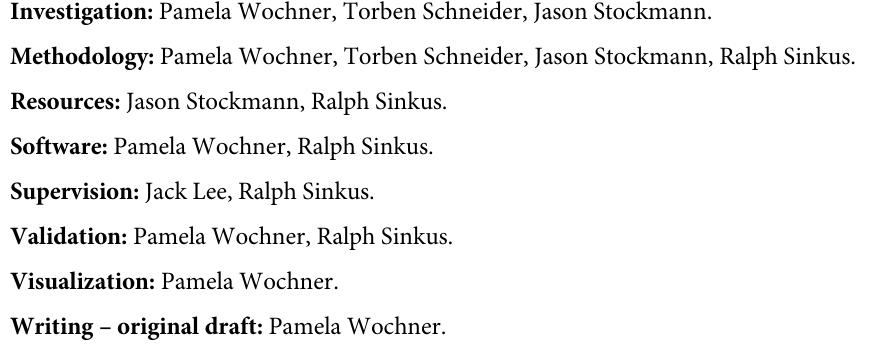
S1 Fig. Simulation and measurement of the magnetic field of the gradient coil. (a) The magnetic field generated by the prototype gradient coil was simulated using the open-source software FEMM. The plot shows the magnitude of the B-field along the z-direction and along the x/y-axis. (b) The magnitude of the magnetic field was also measured using a hand-held Gauss meter. The plot shows the measurements along the